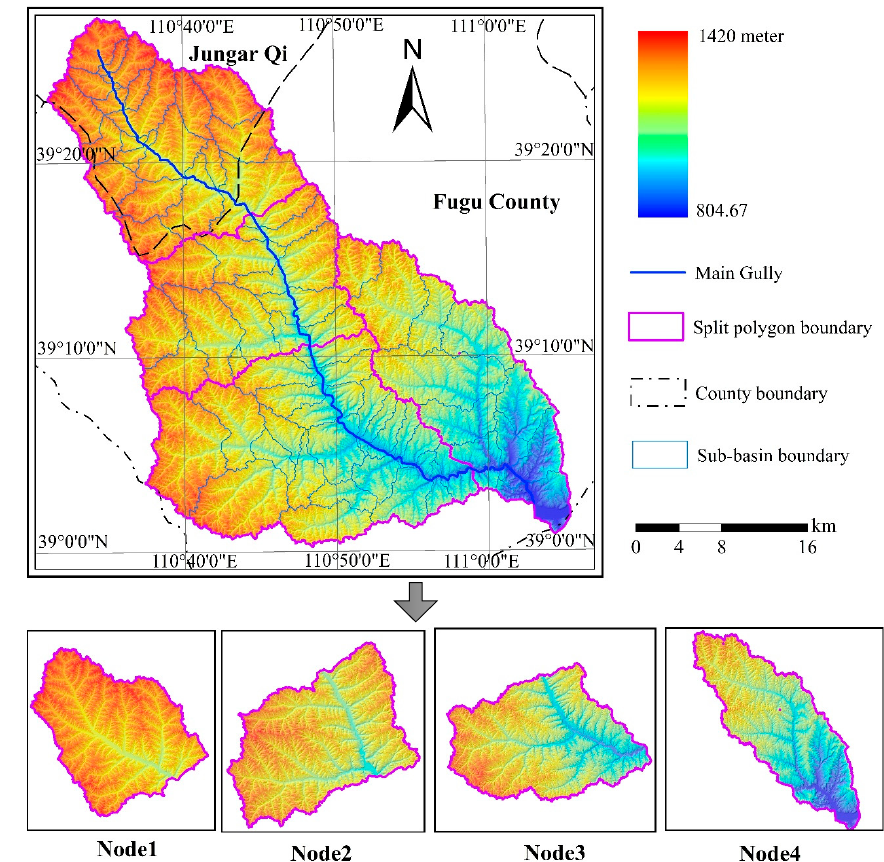
Figure 4. Data splitting by sub-basin with 4 calculation nodes.